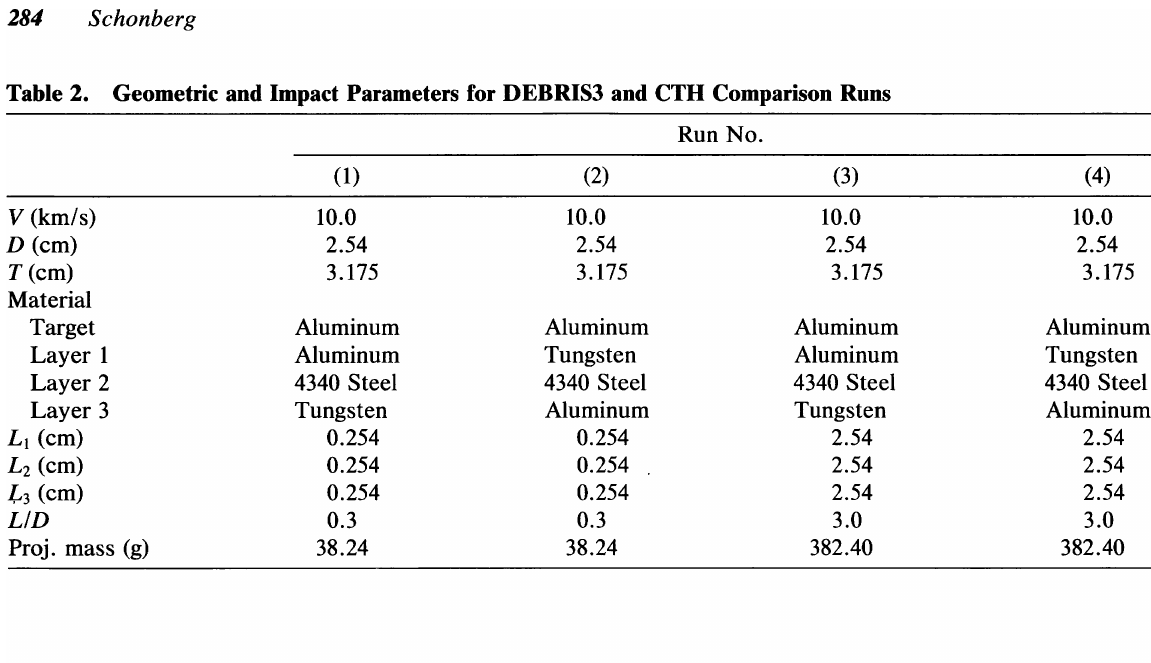
Table 2. Geometric and Impact Parameters for DEBRIS3 and CTH Comparison Runs